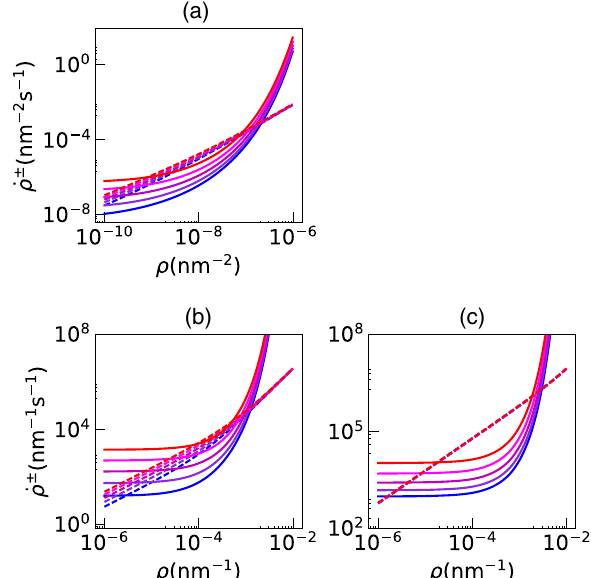
_ ρ þ (solid lines) and _ ρ − (dashed lines) for the nominal set of parameters and an electric field of (from bottom to top) 150, 190, 230, 270, and 310 MV = m, in (a) a model describing mobile dislocation volume density fluctuations, (b) a model with σ ∼ ρ 2 (here Z ¼ 5 × 10 4 ), and (c) a model in which both sessile and mobile dislocations contribute to the average